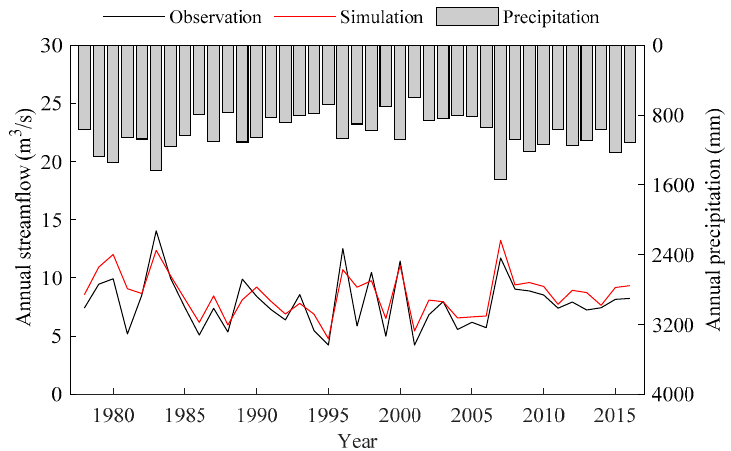
Figure 7. Comparison between annual observed runoff and simulated by SWAT model for the whole period (1978–2016). Table 8. Contribution rates of climate change and anthropogenic activities to runoff variations using SWAT